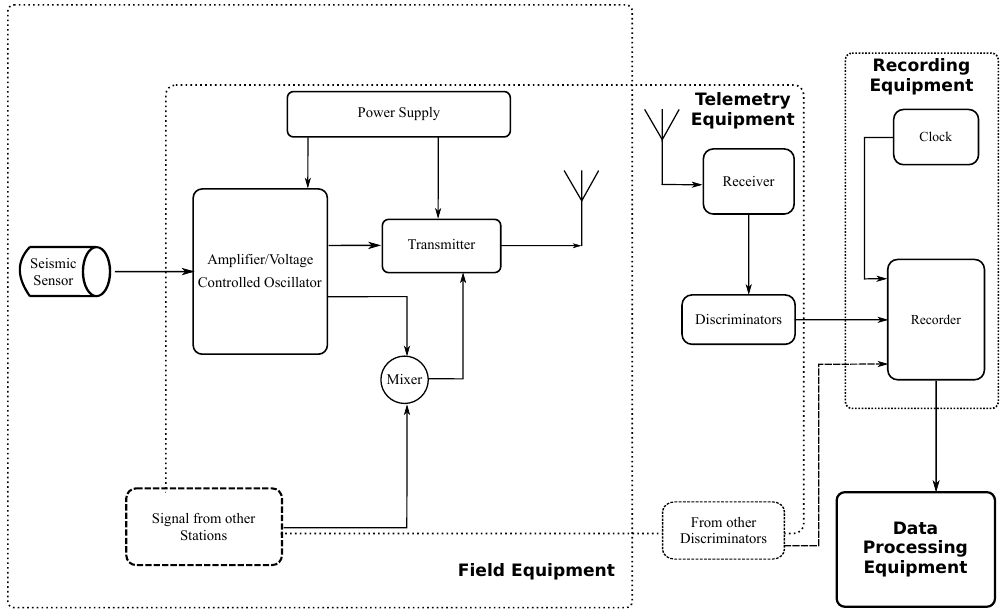
Figure 2. The 1971 analogue micro-earthquake network (Class 2 network) equipped with analogue Willmore photographic seismograph. (Figure adapted after Lynch pers.